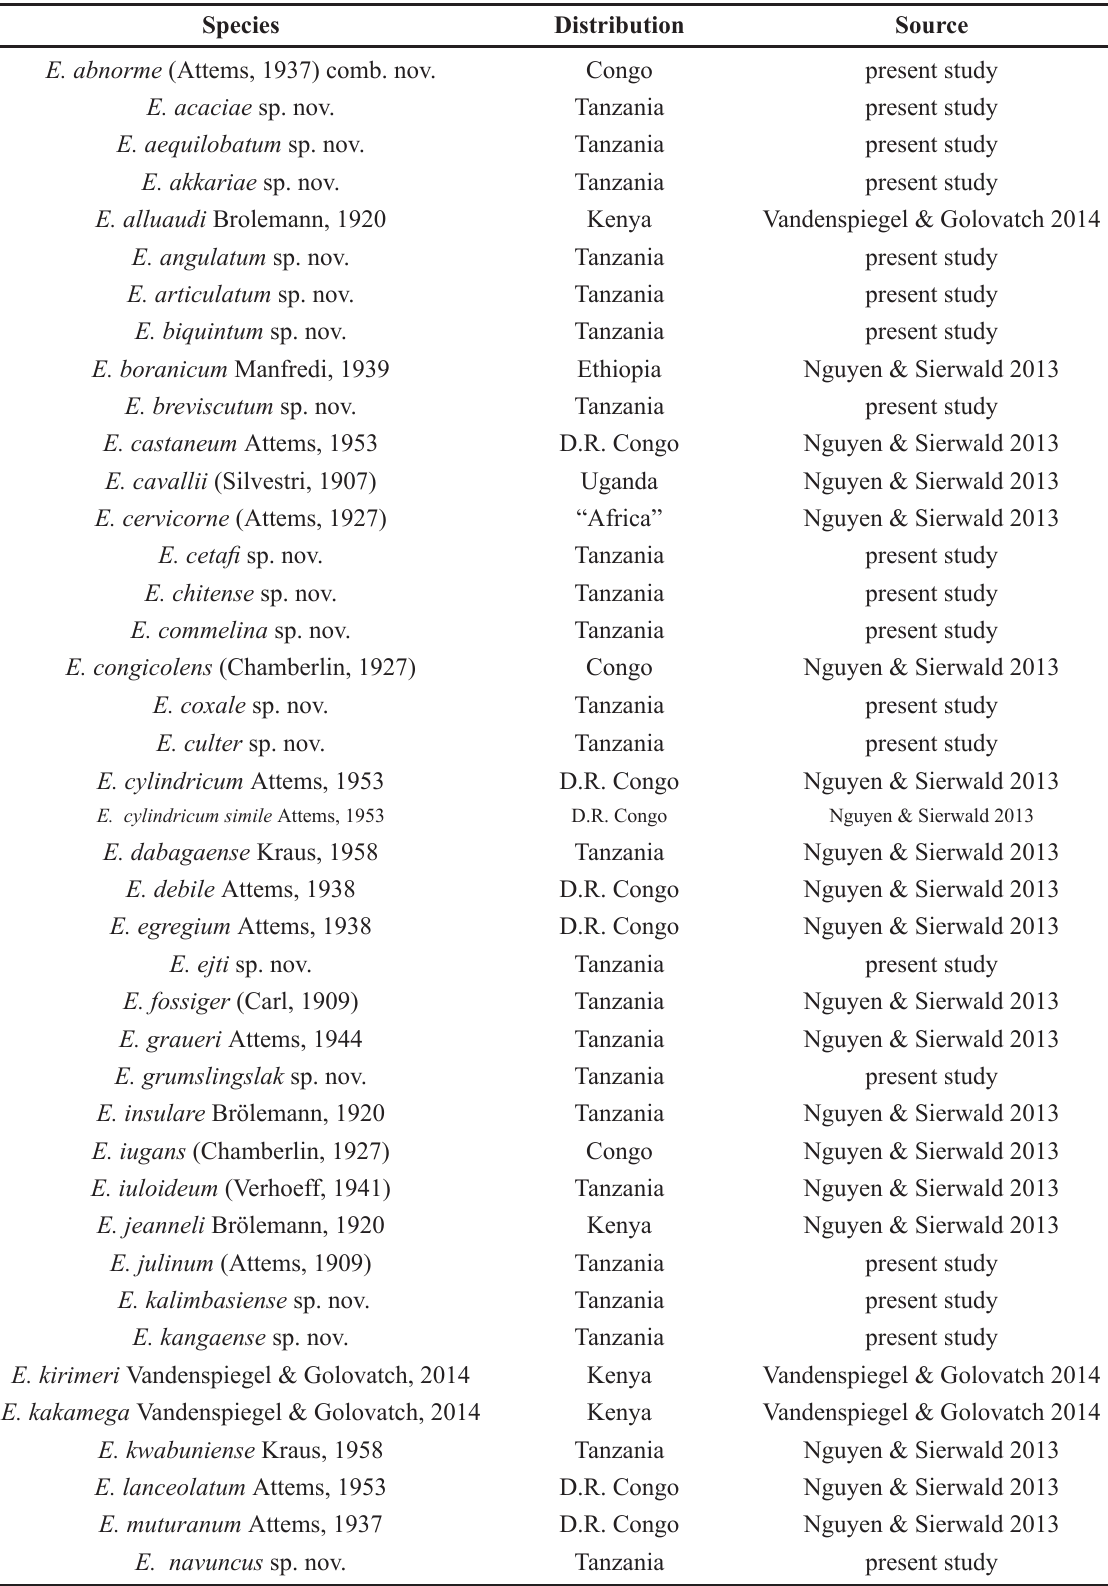
Table 2. Species of Eviulisoma Silvestri, 1910. (continued next page)